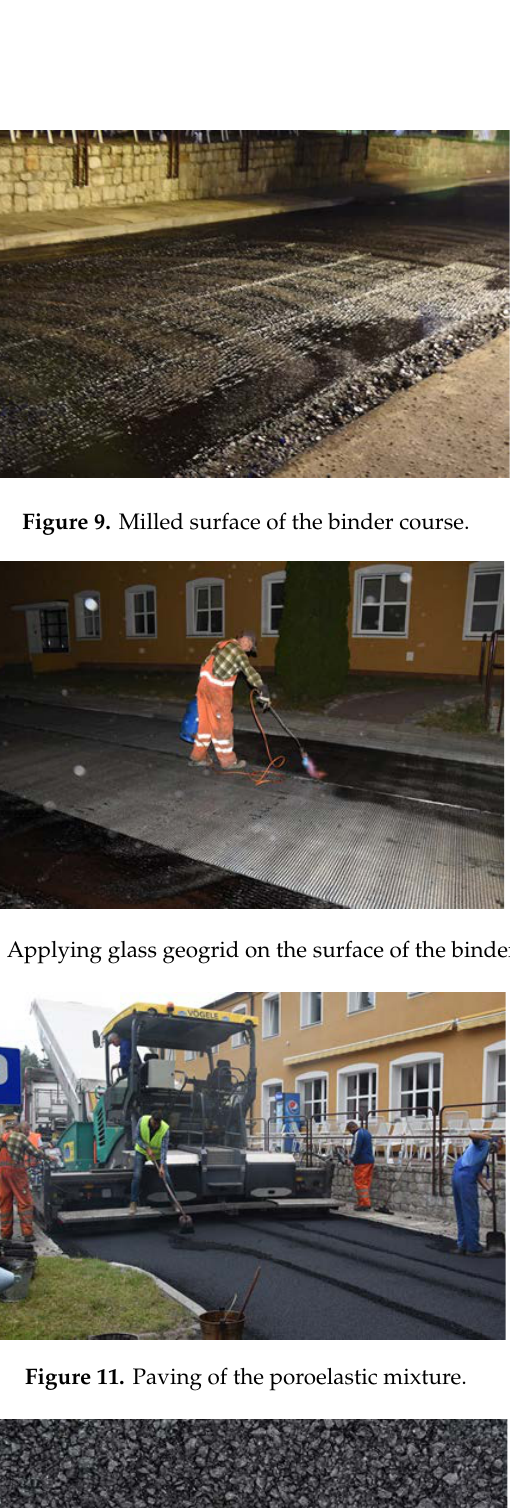
20 of 24 Figure 6. Layout of the Dąbrówka test section. Red numbers designate each section described in text above. Figure 7. Unbound aggregate base course ready for laying the binder course made of AC 16W.